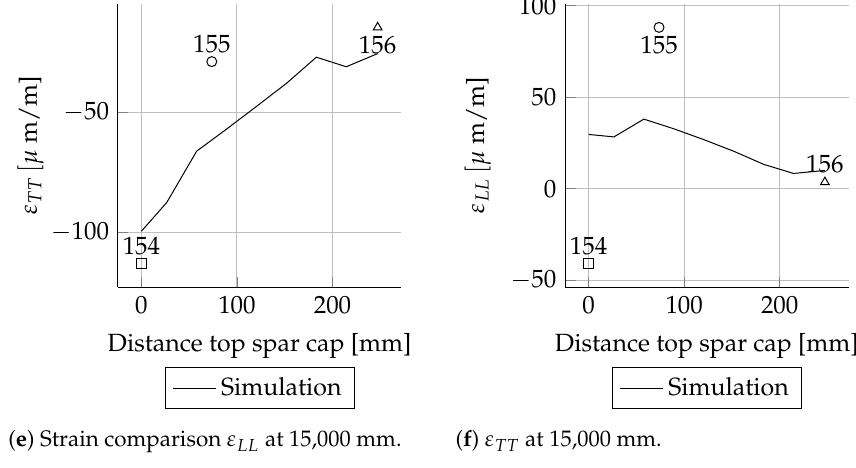
Figure A13. Spar normal strains for Mxmax load case.